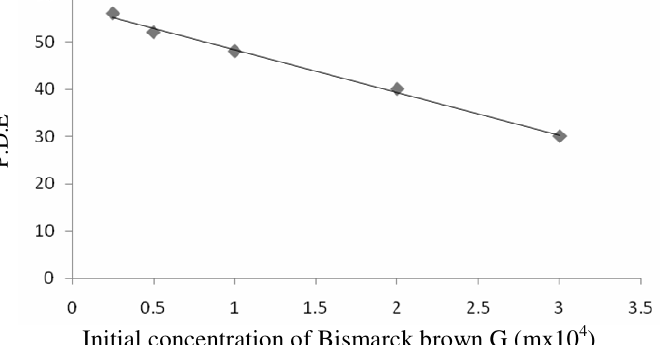
Figure 5 . Effect of initial Bismarck brown G concentrations on